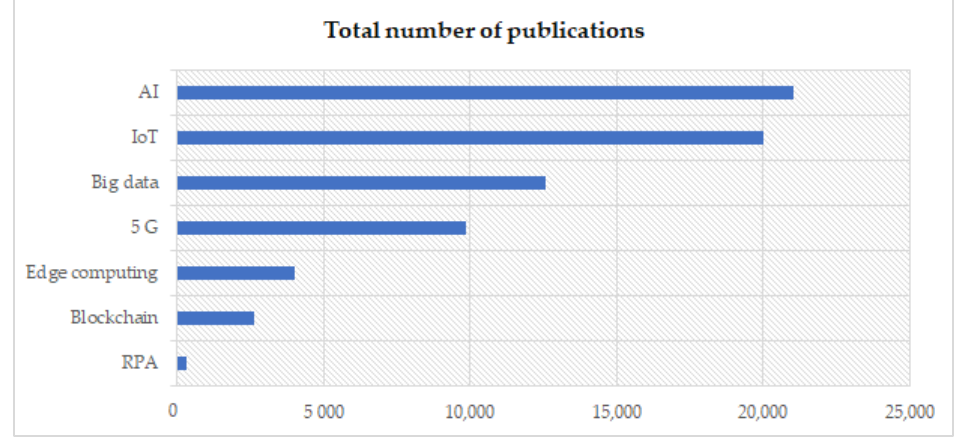
Figure 2. Publication analysis on emerging technologies in the energy industry by technologies (all the years).